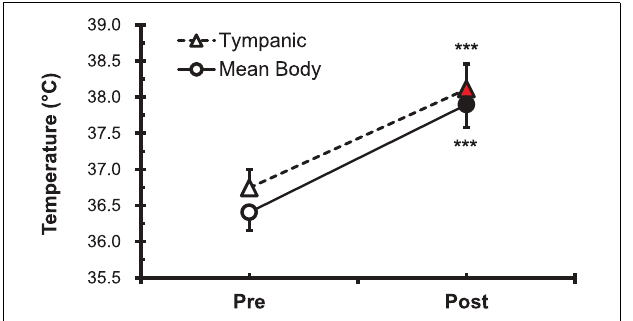
FIGURE 1 | Comparison of tympanic temperature (T ty ) and mean body temperature (mT b ) before (Pre; ◦ , (cid:77) ) and after (Post; • , (cid:78) ) hot water bath (42 ± 0.5 ◦ C) immersion. Values are mean ± SD. *** P < 0.001, statistically significant difference between Pre- and Post-exposure values.